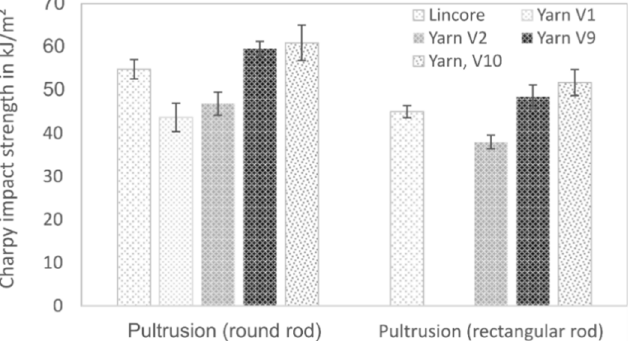
Figure 8. Unnotched Charpy impact strength of pultruded round and rectangular rods (fibre volume fraction of round rods ~40% and of rectangular rods ~30%). Results are shown as mean values with standard deviation as error bars.